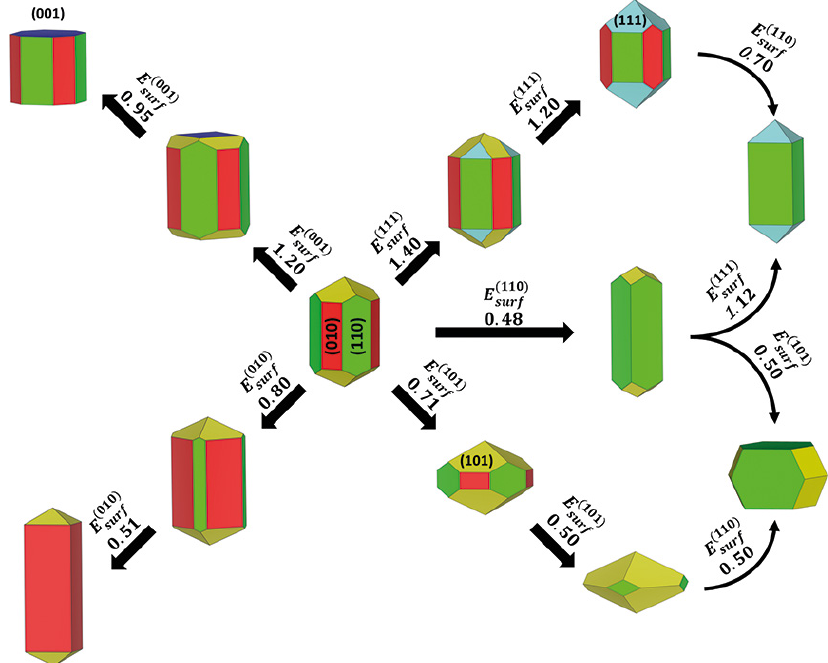
. The arrows indicate a decrease of the surface 2